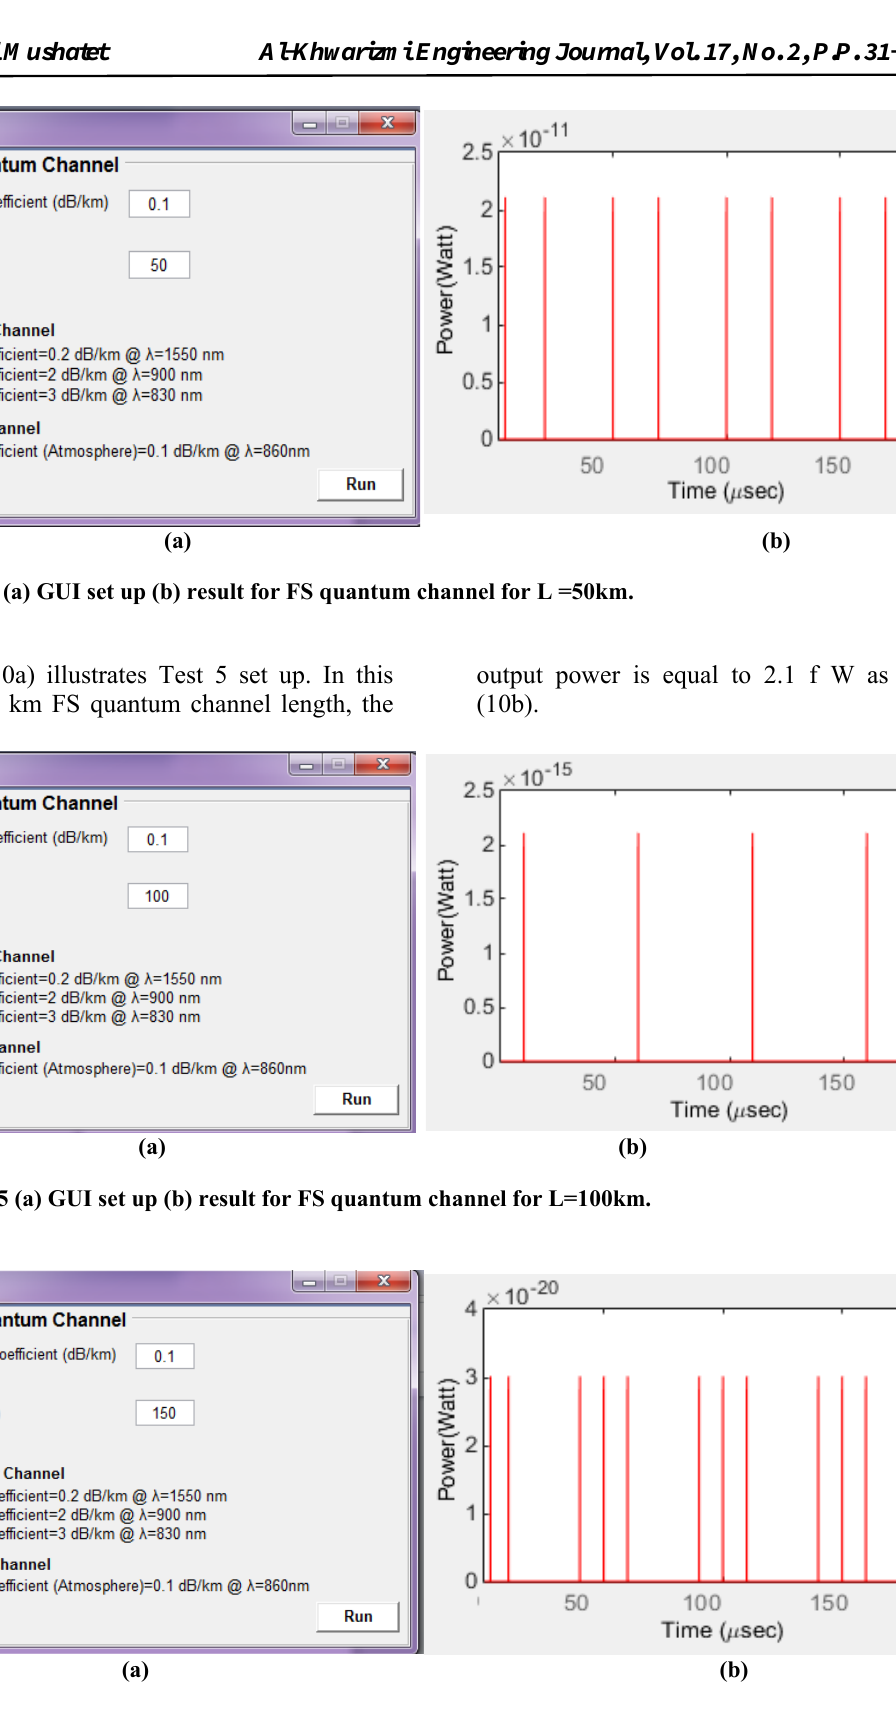
Fig. 11. Test 6 (a) GUI set up (b) result for FS quantum channel for L